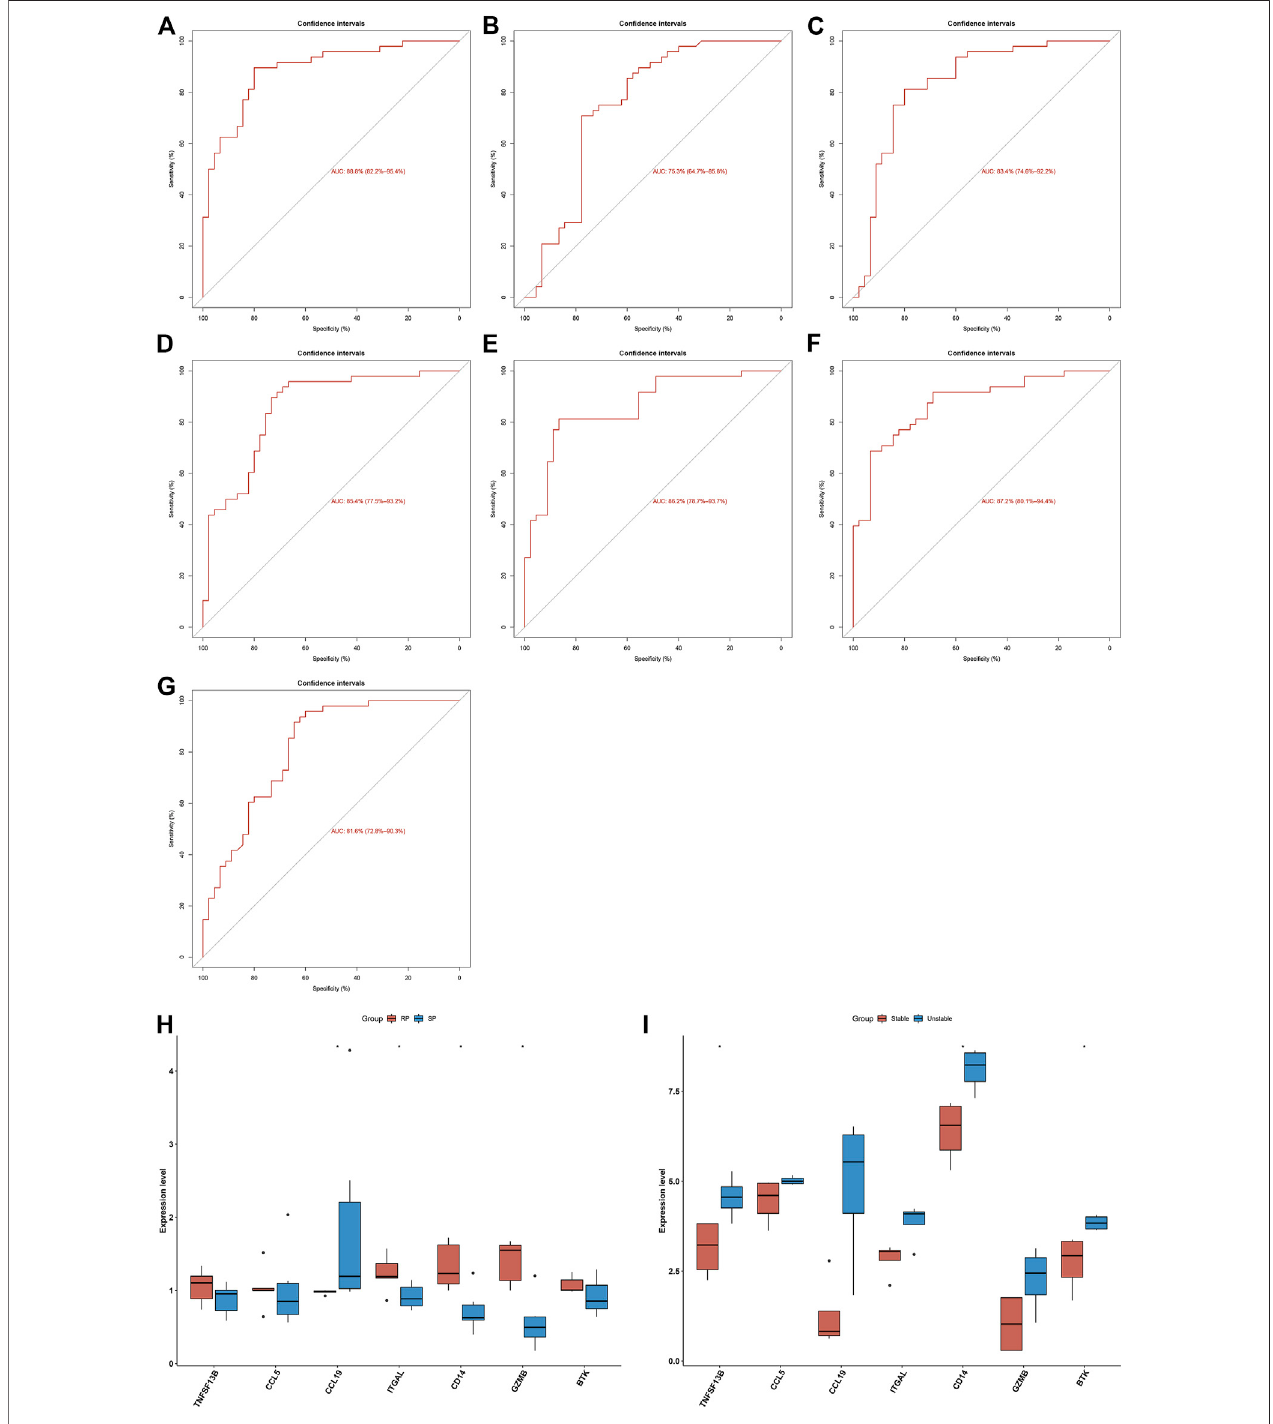
FIGURE 4 | Diagnostic ef fi cacy of characteristic genes in the prediction of atherosclerotic plaque progression and external veri fi cation of expression of characteristicgenes. (A – G) ROCcurvesestimating thediagnosticperformanceofcharacteristicgenes (A) BTK, (B) CCL5, (C) CCL19, (D) CD14, (E) GZMB, (F) ITGAL, and (G) TNFSF13Binpredictingatheroscleroticplaqueprogressioninthecombined GSE28829andGSE43292datasets. (H) BoxplotsshowingthemRNAexpression of characteristic genes in ruptured and stable atherosclerotic plaque in the GSE41571 dataset. RP: ruptured plaque; SP: stable plaque. (I) Box plots showing the mRNA expression of characteristic genes in stable and unstable atherosclerotic plaque specimens in the GSE120521 dataset. * p < 0.05.